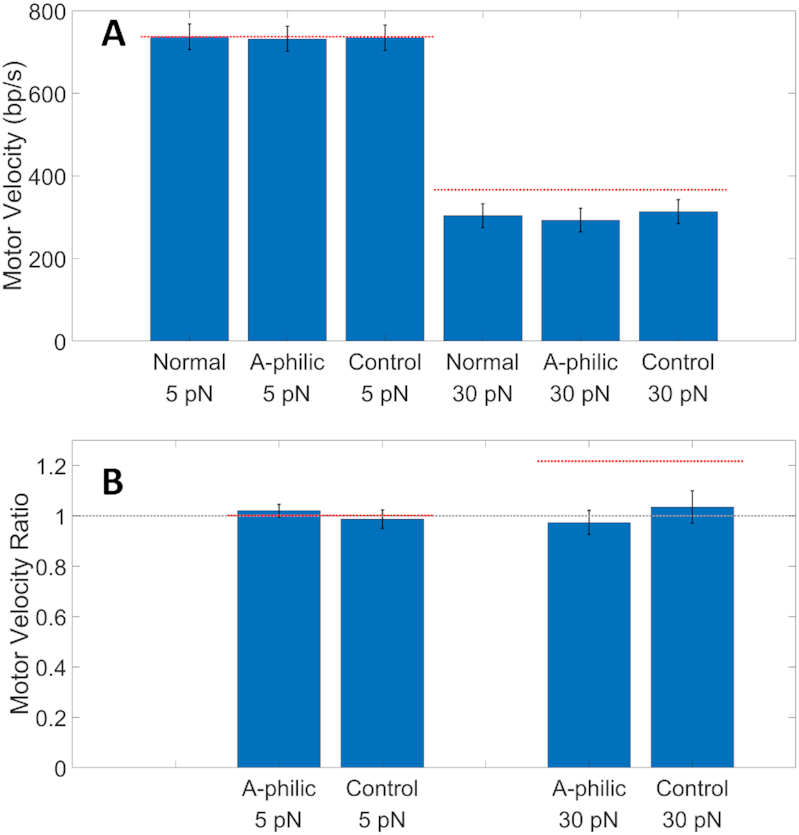
(A) Average motor velocities. ‘Normal’ refers to measurements with the non-A-philic flanking sections I and III of the linear plasmid DNA sequence, ‘A-philic’ to section II, and ‘Control’ to the phage DNA sequence. Averages were determined from 134 recorded events at 5 pN and 45 recorded events at 30 pN for the linear plasmid sequence and 80 events at 5 pN and 50 events at 30 pN for the control DNA. Error bars indicate standard errors in the means. The horizontal lines indicate the velocity for the A-philic sequence predicted by the B-A scrunchworm model and force–velocity relationship. (B) Average velocity ratios. Bars labeled ‘A-philic’ refer to the average ratio of the velocity when packaging the A-philic segment to that when packaging the normal flanking plasmid segments calculated for each event. Bars labeled ‘control’ refer to velocity ratios calculated in the same manner for events recorded with the phage DNA. Error bars indicate standard errors. The dashed gray line indicates a ratio of ‘1’, expected if there is no sequence dependence. The horizontal lines indicate ratios predicted by the B-A scrunchworm model and measured force–velocity relationship.